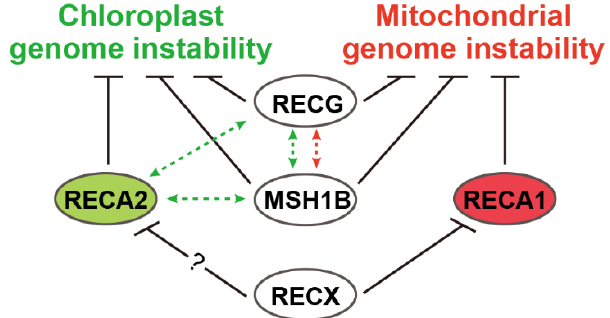
Figure 1. Factors affecting organelle genome stability in P. patens . Factors involving organelle genome stability are summarized with their relationship. Protein localization of the factors are shown by their colors: green (chloroplasts), red (mitochondria), and white (chloroplasts and mitochondria). Suppression and genetic relationship are shown by solid and dashed lines, respectively. RECX shows protein–protein interaction with RECA2, but its involvement in chloroplast genome stability remains unclear.